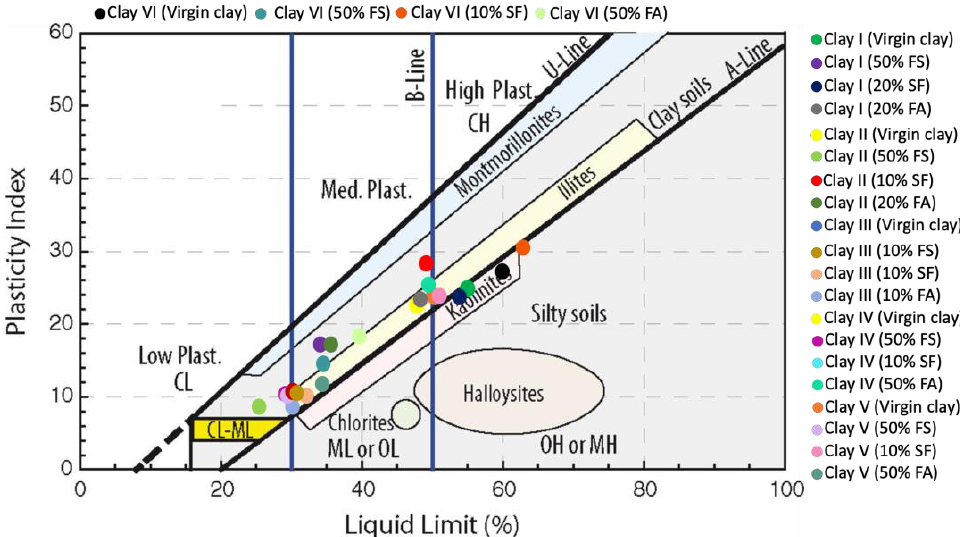
Figure 14. Location of clay and modified clay specimens on the combined Holtz and Kovacs diagram and Casagrande plasticity chart.